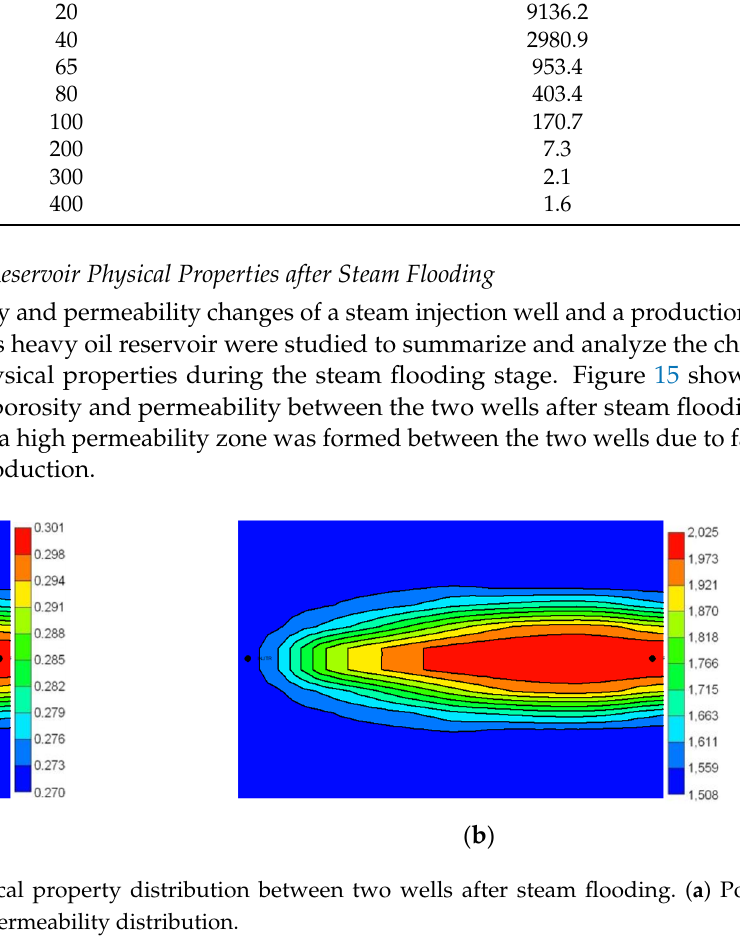
Table 5. Viscosity-temperature relationship [30].